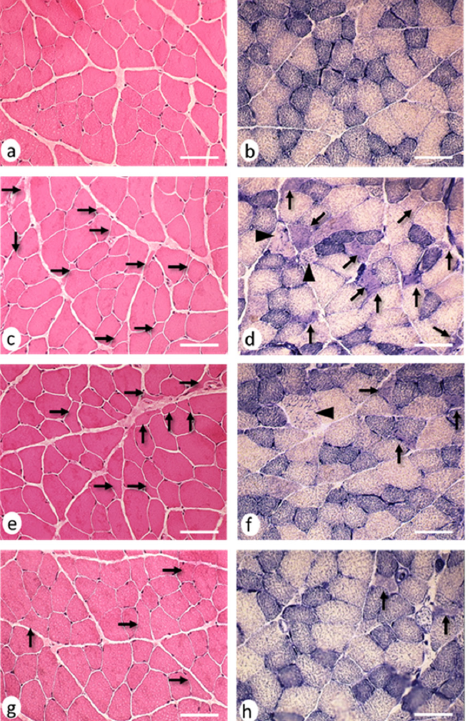
Figure 4. Neurogenic lesions in EDL muscles at day 36. Cross-sections corresponding to ( a ) the control group: muscle fibers showing normal morphology coloration; ( b ) control group: three types of muscle fibers were observed based on their histochemical activity, type 1 (dark), type 2b (light), and type 2a (intermediate); ( c ) EAE group: angulated atrophic fibers (arrows) scattered among apparently normal muscle fibers; ( d ) EAE group: angulated atrophic muscle fibers (arrows) with homogeneous staining and punctiform accumulations of oxidative activity, while other atrophic fibers with rounded contours showed patchy enzymatic activity (moth-eaten fibers; arrow heads); ( e ) EAE + NTZ group: fewer angulated atrophic muscle fibers were observed (arrows); ( f ) EAE + NTZ group: one moth-eaten fiber (arrowhead) and two angulated atrophic muscle fibers; ( g ) EAE + TMS group: the arrows mark several fibers with an angulated profile, although they did not appear atrophic; ( h ) EAE + TMS group: only two atrophic fibers with angular contours were observed (arrows). Images a–g, hematoxylin and eosin staining; images b–h, nicotinamide adenine dinucleotide tetrazolium reductase (NADH-tr) staining. Scale bars = 40 μ m.